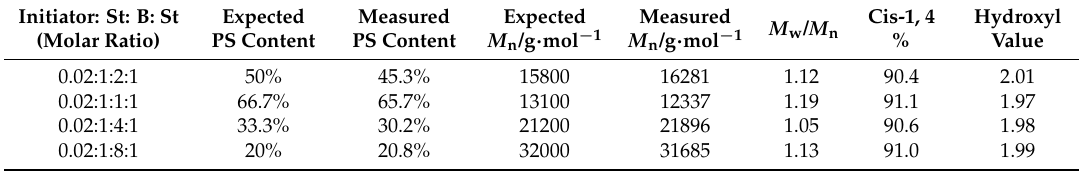
Table 1. Characterizations of HO–SBS–OH synthesized by [ η 3 -Ni(CH 2 CHCHCH 2 OOCH 3 )][BPh F 4 ]. Initiator: St: B: St (Molar Ratio)